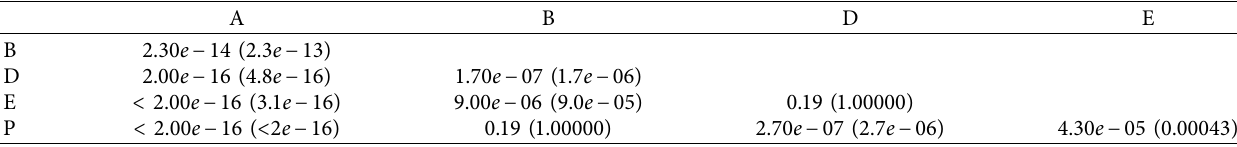
Table 12: In L-Space, for AVL, CFL, RGTR, and TICE networks, pI � 0.05, pR � 0.0025, and T � 65, p -value of the Wilcoxon rank sum test (resultant p -value per Bonferroni correction is indicated in